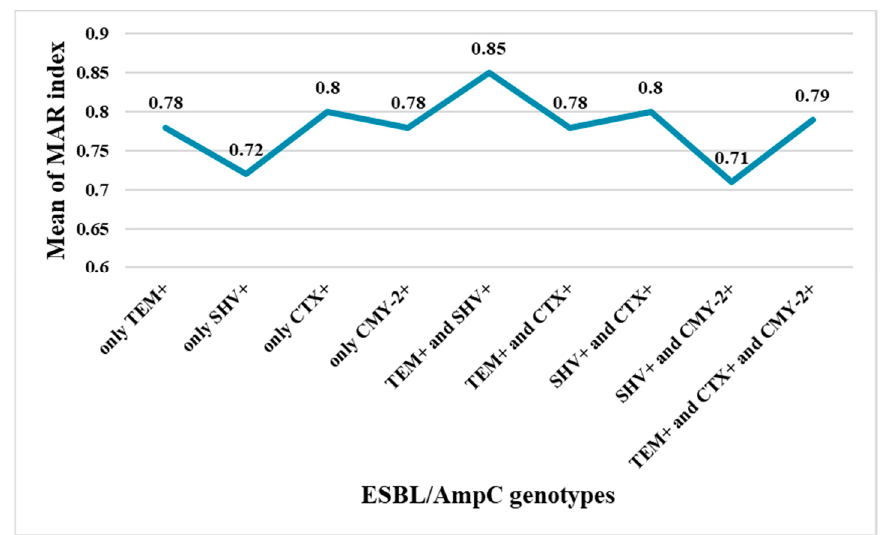
Figure 4. Distribution of mean values of MAR indices among the detected ESBL- or AmpC-producing E. coli isolates.